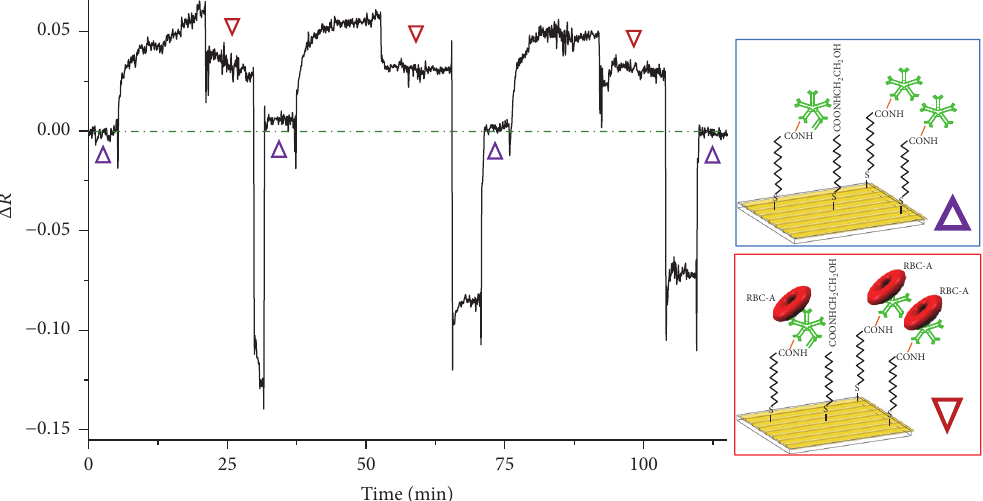
Figure 5: LR-SPR kinetic curve showing detection of red blood cells (RBCs) and regeneration of the surface using 20 mM NaOH. PBS buffer was used to obtain a baseline reading ( Δ ) and then RBC-A is bound on the Anti-A for ∼ 5min, before the surface is rinsed with PBS buffer ( ∇ ). Then, 20 mM NaOH is injected on the RBC-A/Anti-A surface, followed by the injection of PBS buffer ( Δ ).